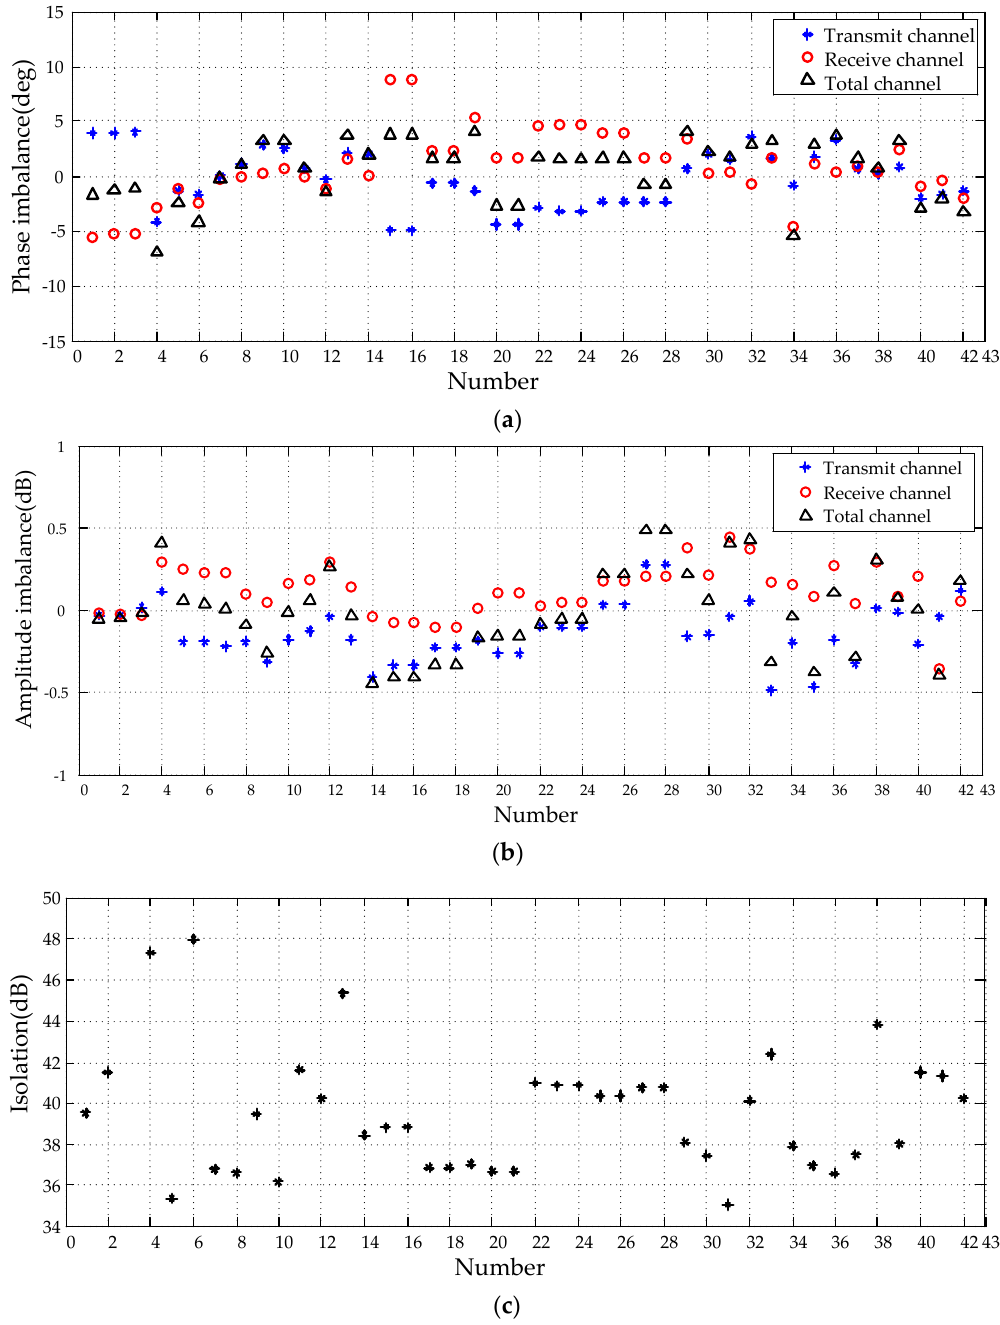
Figure 8. Quality assessment results of corrected data estimated by distributed-target method: ( a ) amplitude imbalance; ( b ) phase imbalance; and ( c ) isolation.